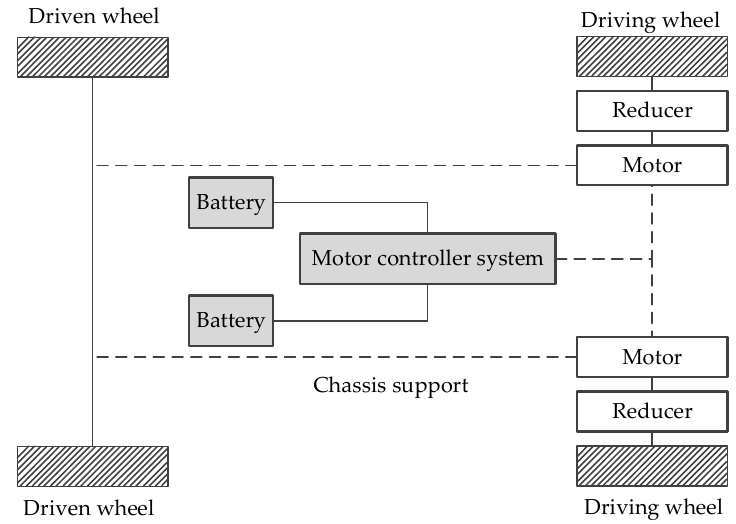
Figure 1. Structural diagram of dual motor dual-wheel distributed independent drive system.